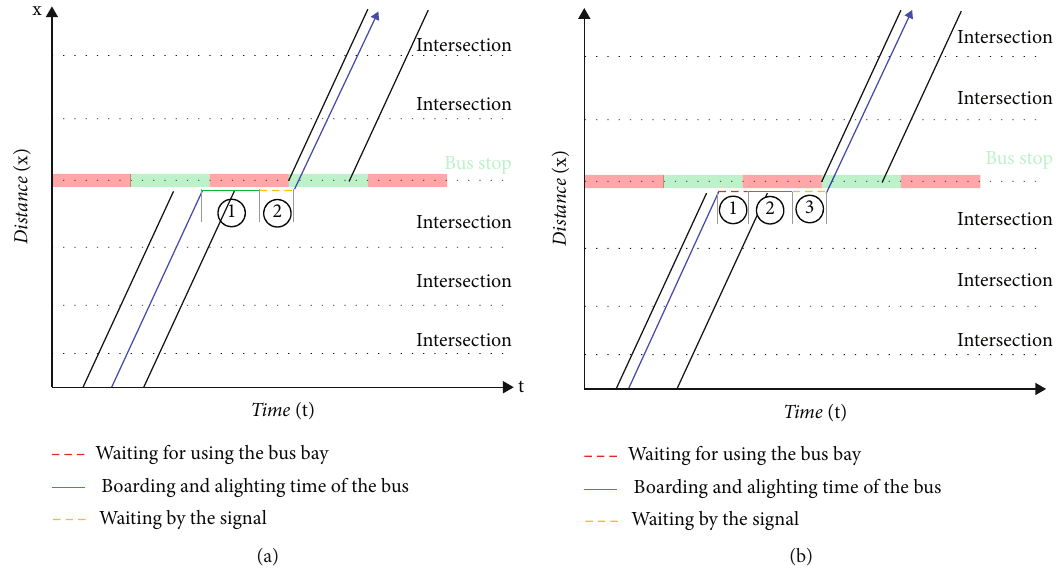
Figure 2: Bus trajectories at a near-side stop (a) without and (b) with a bus bay